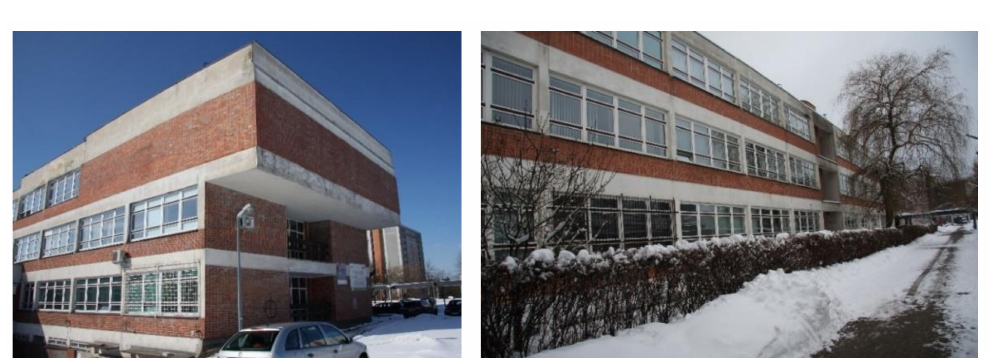
Figure 2. View of tested building (part A) before thermomodernization, with characteristic stripes of clinker brick under the windows [photo